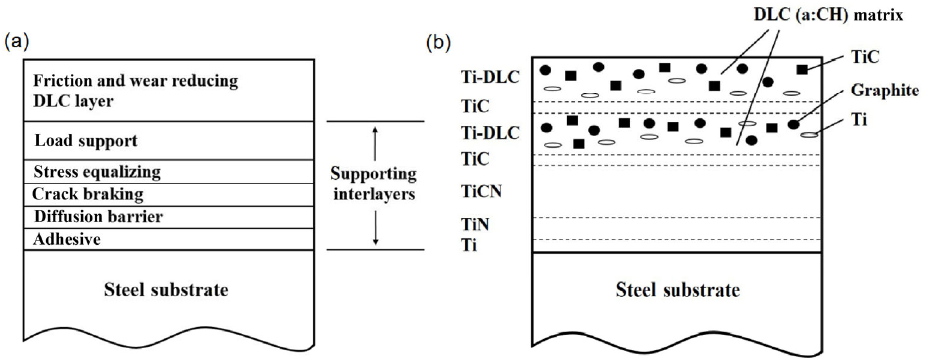
Fig. 3 (a) Schematic representation of individual layers and their functionality in a multilayer coating system. (b) Example of a functional multilayer coating developed for steel surface protection against wear. Adopted from Ref. [7], with permission from